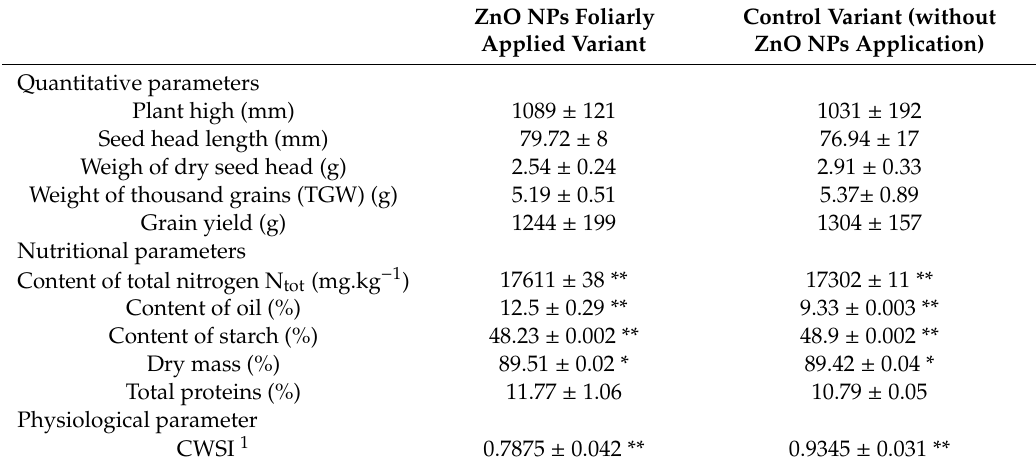
Table 4. Comparison of foxtail millet quantitative, nutritional, and physiological parameters in the zinc oxide nanoparticles (ZnO NPs) foliarly applied variant and the control when harvested after 95 days. This included the standard deviation ( ± SD) and calculation by Fisher’s least significant di ff erence (LSD)